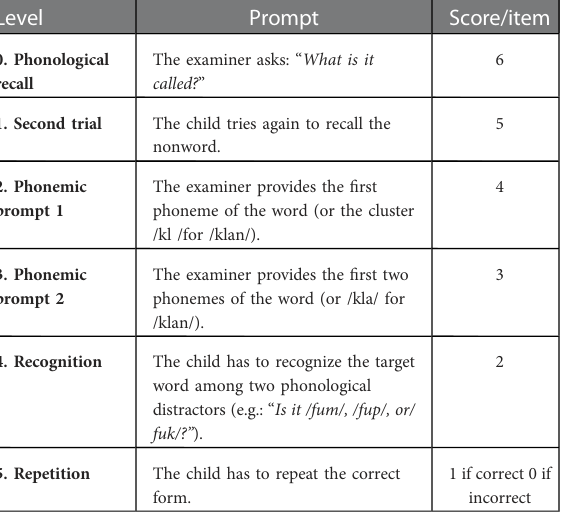
TABLE 3 Phonological recall: prompts and scores. Level